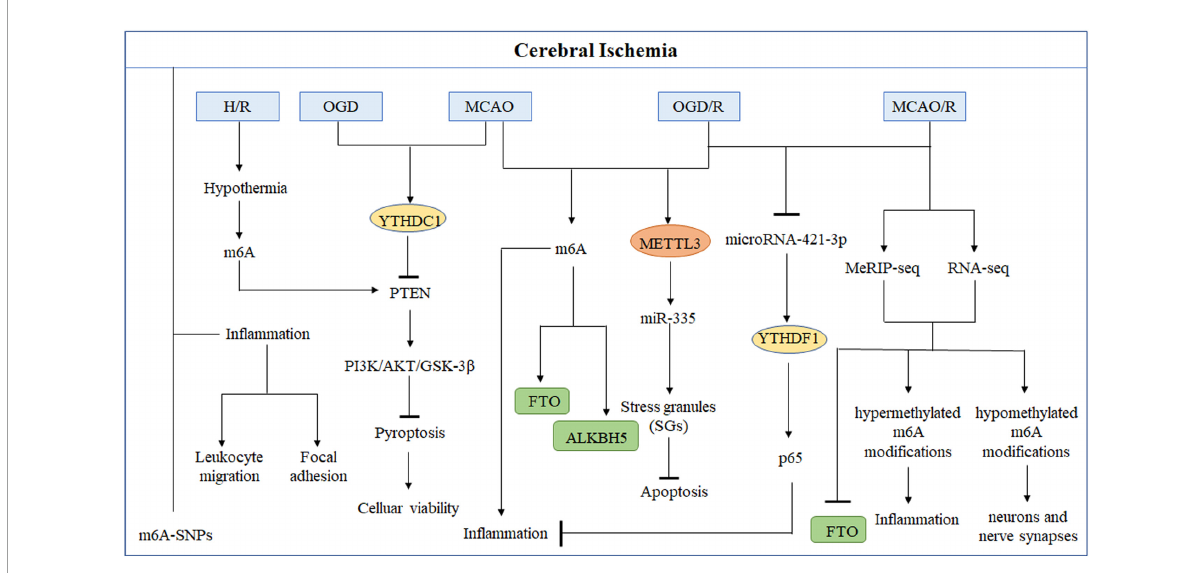
FIGURE2 Role of m6A modifications in cerebral ischemia. Methyltransferases or demethylases regulated modulations in the levels of m6A modification and the effects of m6A binding proteins in the occurrence and development of stroke in different types of cerebral ischemia models.